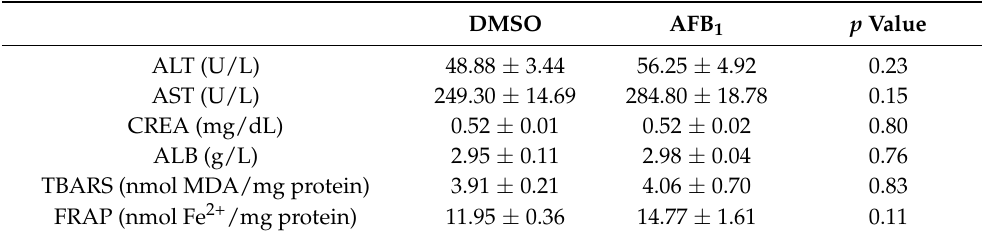
Table 2. Effect of intermittent administration of AFB 1 (250 µ g/kg b.w., i.g.) or 2% DMSO (10 mL/kg b.w., i.g.) in plasma biochemical parameters.